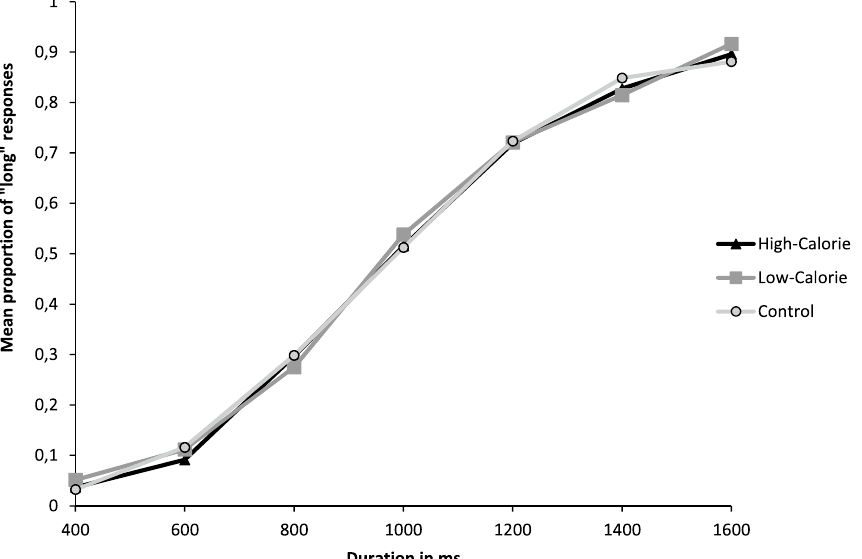
Figure 2. Mean proportion of “long” responses plotted against stimulus duration for each of the picture